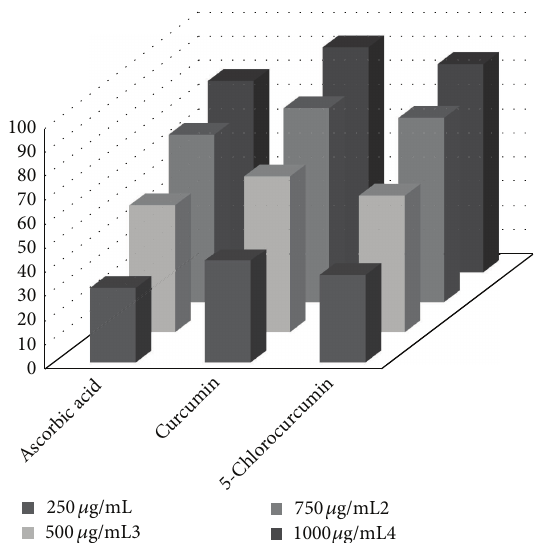
Figure 4: Scavenging effect of 5-chlorocurcumin, curcumin, and ascorbic acid at different concentrations (15, 30, 45, 60, 80, and 100 𝜇